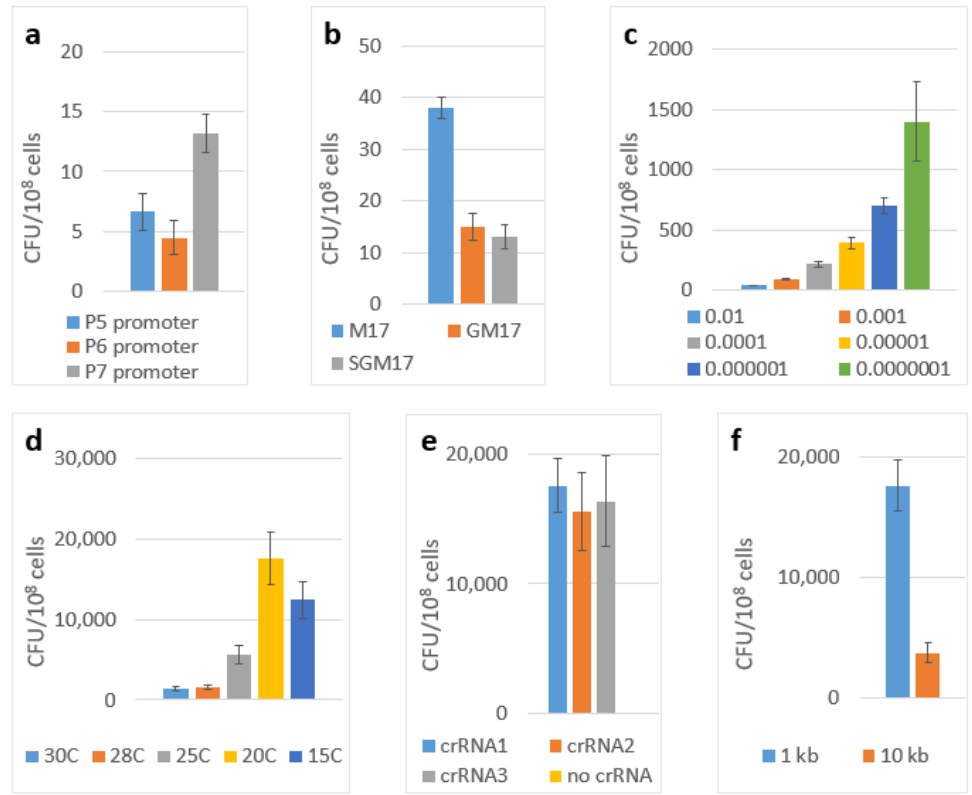
Figure 1. Transposition efficiencies. The number of chloramphenicol-resistant (cm) CFUs per 10 8 cells of L. lactis IL1403 which were transformed by the two-plasmid genome-editing system depending on: ( a ) transcription promoter used; ( b ) the carbon sources of solid medium; ( c ) the inoculum size; ( d ) the incubation temperatures; ( e ) the guide RNA choice; ( f ) the total size of the integrating fragment. The error bars indicate the standard deviation values from three biological replicates.